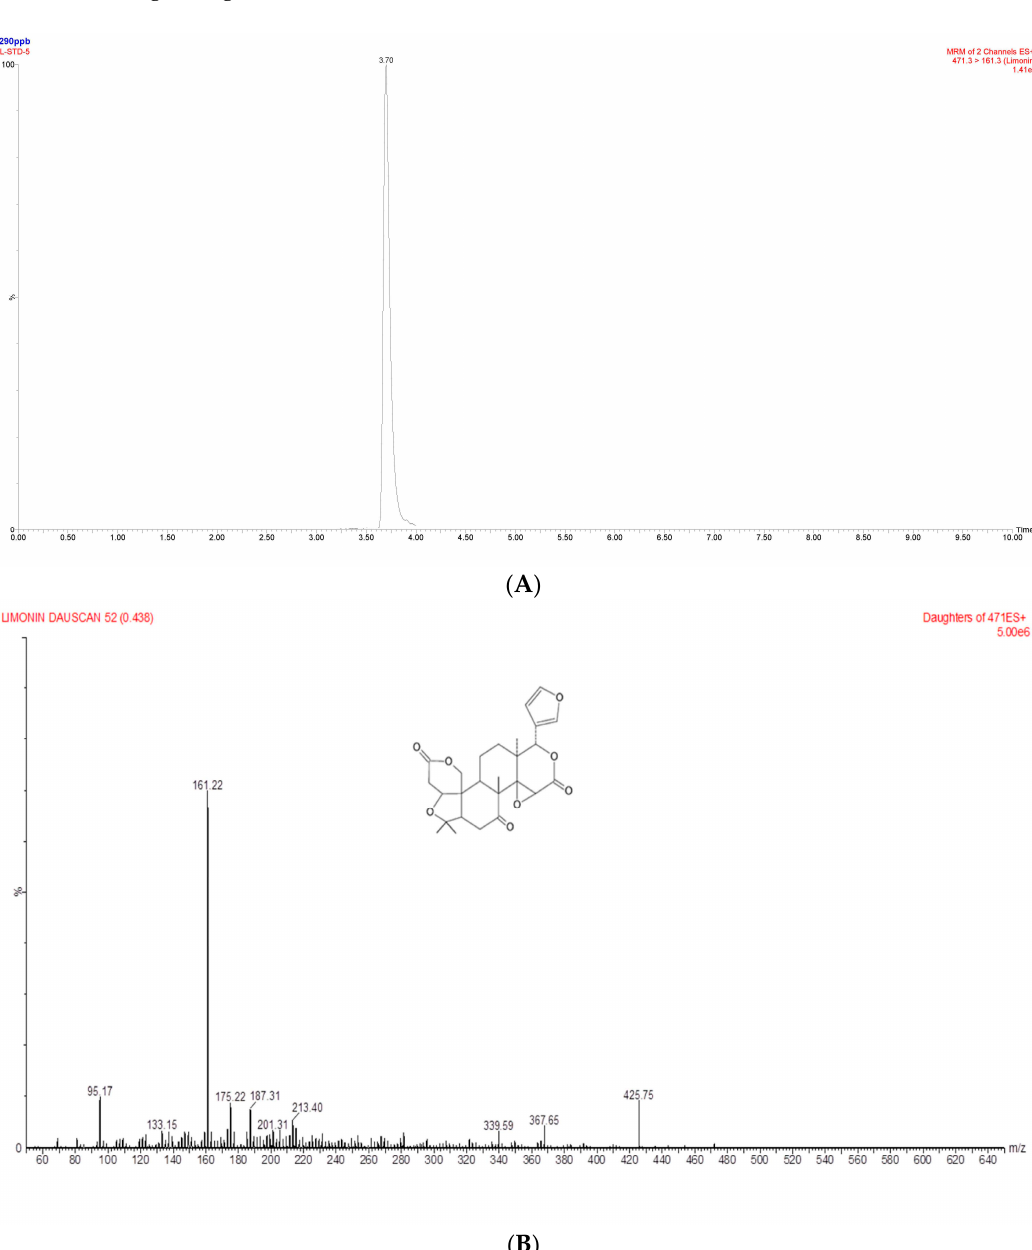
Figure 3. ( A ) Representative UPLC-MS/MS chromatograms of limonin; ( B ) Full-scan product ion spectra of [M + H] + ions and fragmentation pathways for limonin.